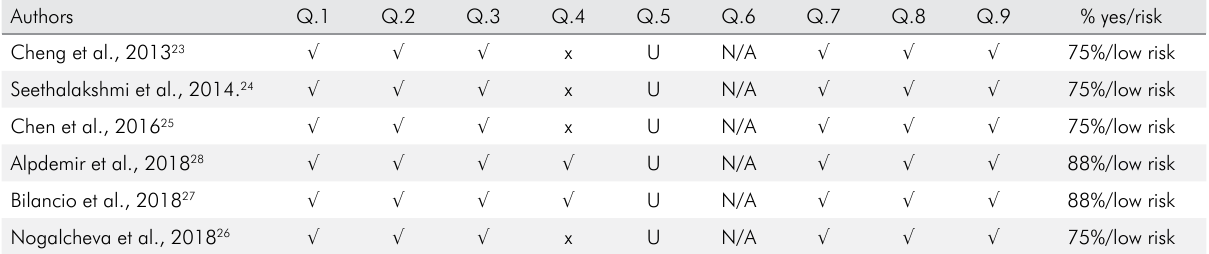
Table 5. Risk of bias assessed by the Joanna Briggs Institute Critical Appraisal Tools for use in JBI Systematic Reviews for Quasi- experimental